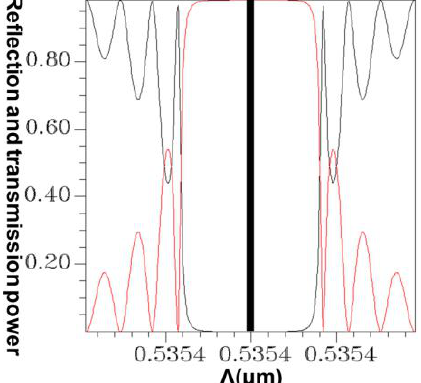
Figure 18. Plot between the FBG period and the reflection (or transmission) power for the total counterpropagating HE . The black line expresses the core mode and cladding modes 11 transmission power. The red line expresses the core mode and cladding modes reflection